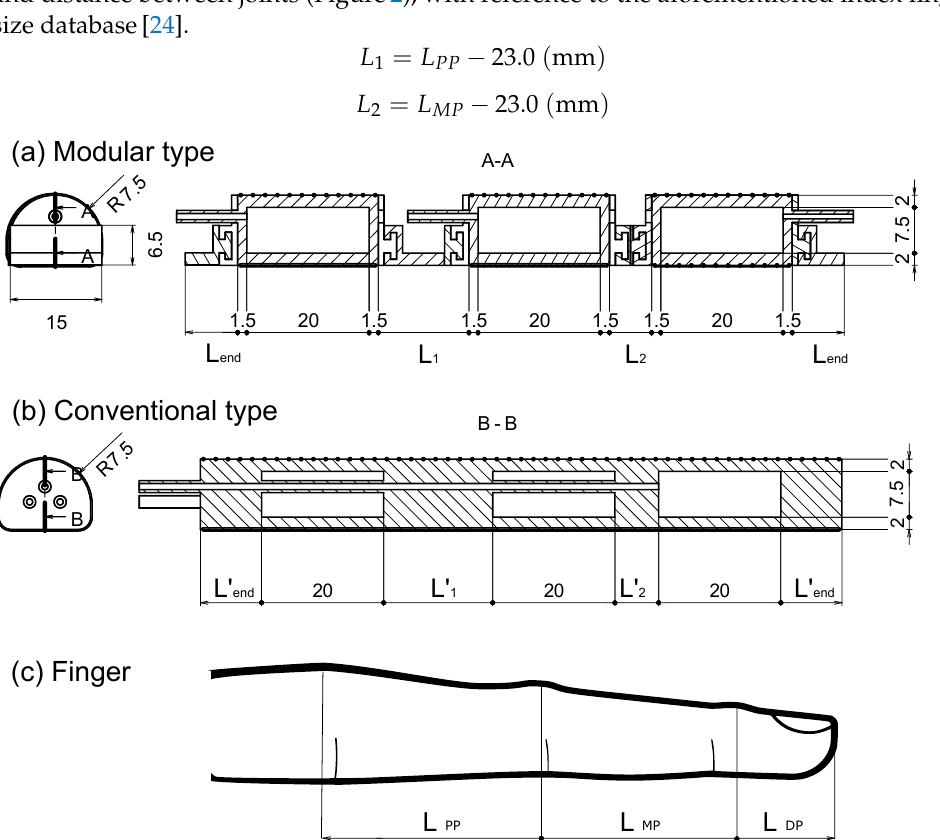
Figure 2. Cross sections and dimensions of the each type of soft actuator. ( a ) Modular type; ( b ) con- ventional type; ( c )